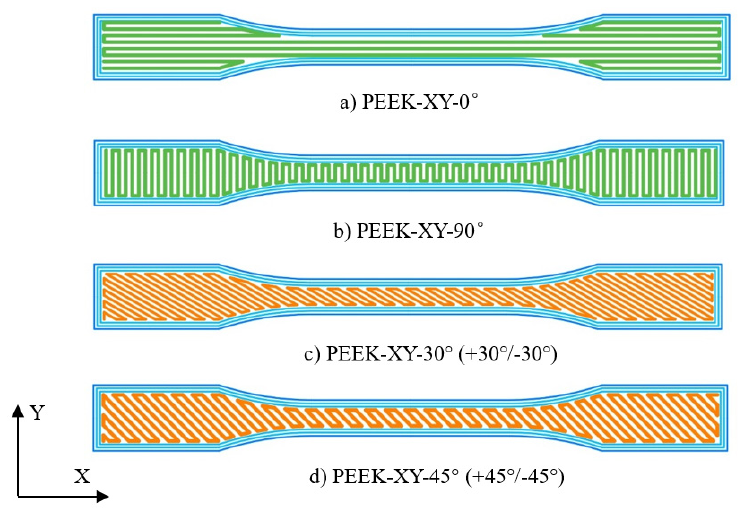
Figure 2. The schematic diagram of the printing path with different raster angles for tensile sam- ples.